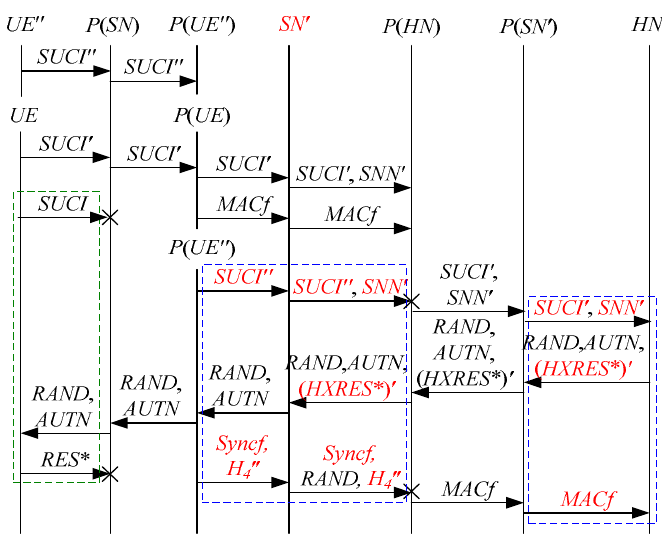
Figure 4. The third attack scenario of the 5G AKA protocol.